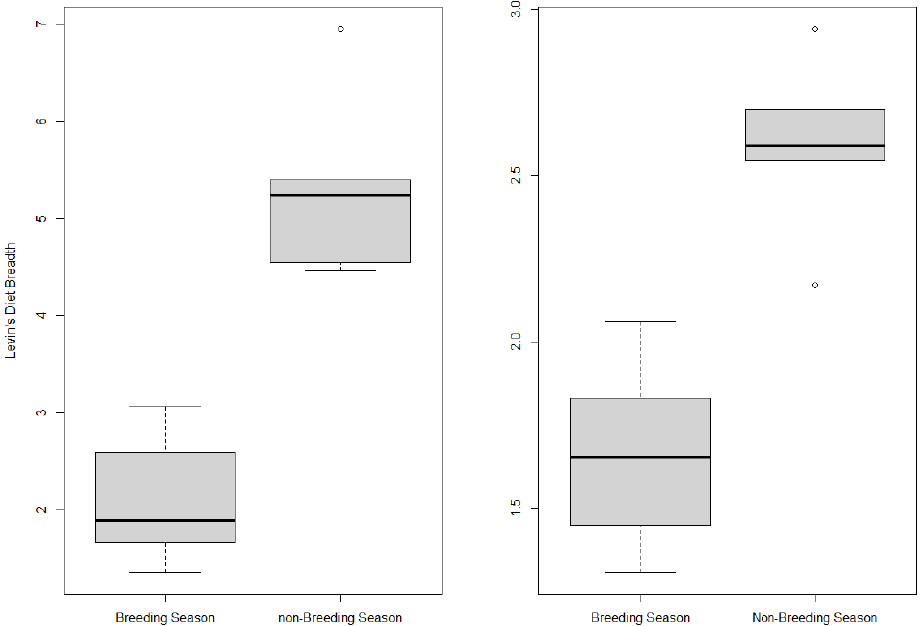
Figure 2. Seasonal Levin’s diet breadth indices on the basis of 13 prey categories (see Table 1) ( left ), and the three broad taxonomic classes (birds, mammals, reptiles) ( right ).